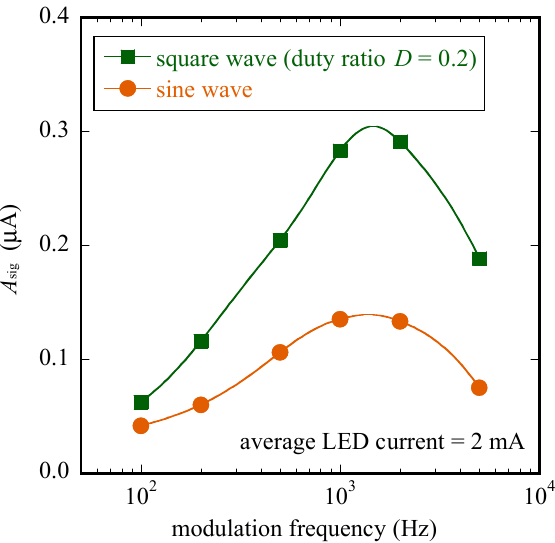
Figure 5. Comparison of values of the amplitude of fundamental frequency ( 𝐴 sig ) obtained with a sine and a square wave with a low duty ratio ( 𝐷 = 0.2 ) in a frequency range from 100 to 5000 Hz.